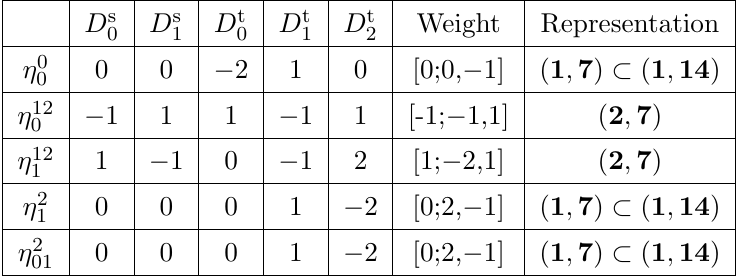
Table 7 . Weights and representations of the components of the generic curve over S \ T in Resolution III of the SU(2) (cid:2) G 2 -model. See section 4.2 for more information on the interpretation of these representations.